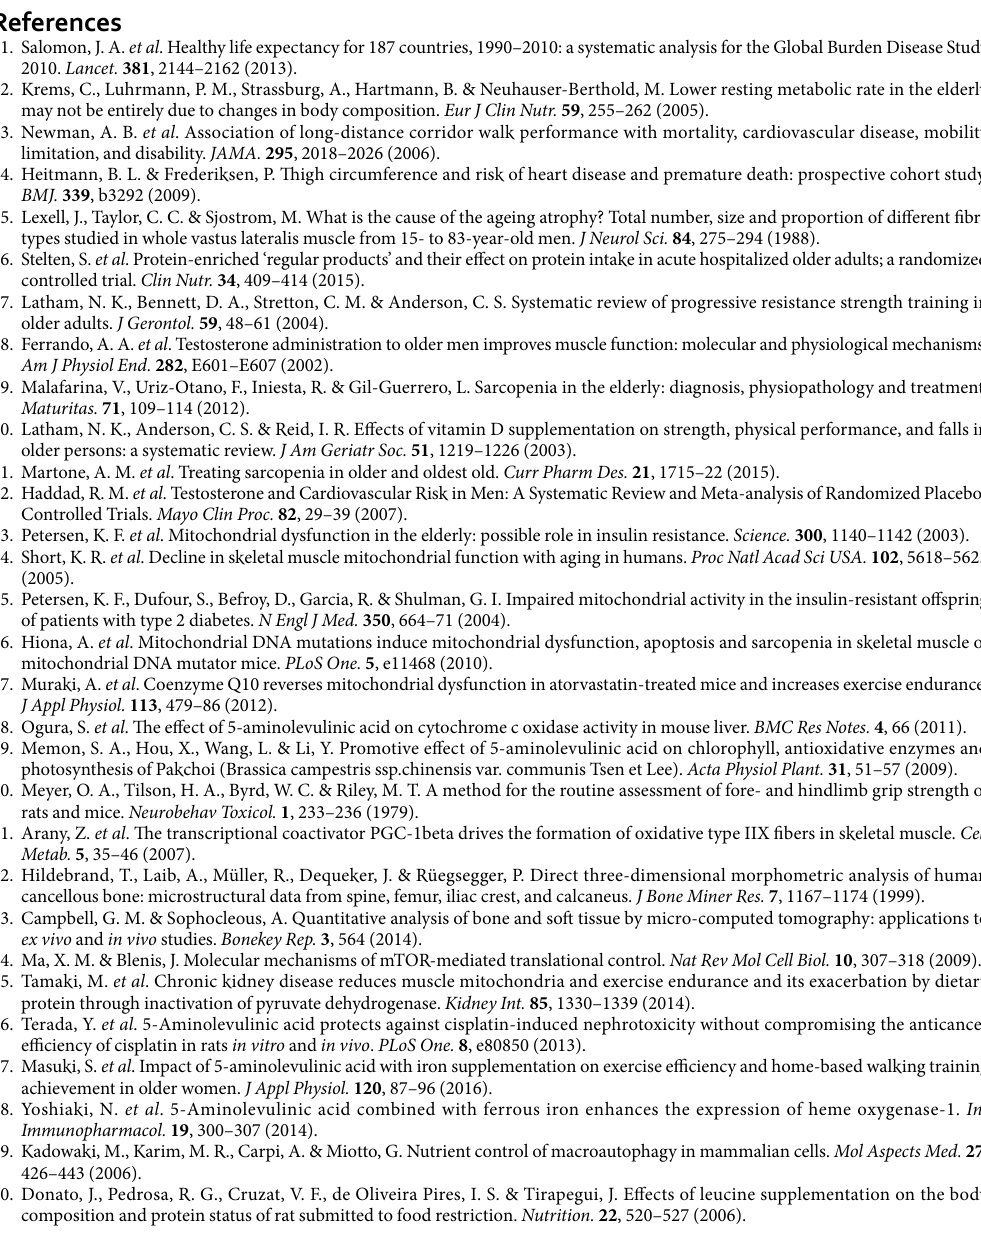
increases in metabolic diseases and cardiovascular diseases. Mitochondrial activation with ALA is expected to contribute to true sarcopenia treatment that not only enhances muscle mass and physical performance but also ameliorates glucose tolerance and brings about an improved cardiovascular prognosis.